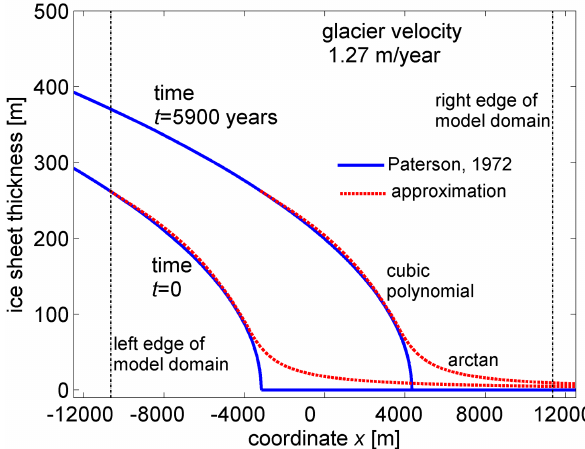
Figure 3. Distribution of the glacier thickness in the ice sheet marginal zone. The exact glacier shape is shown with a solid line and the approximation to the exact shape, used in the computational simulations, is shown with a dashed